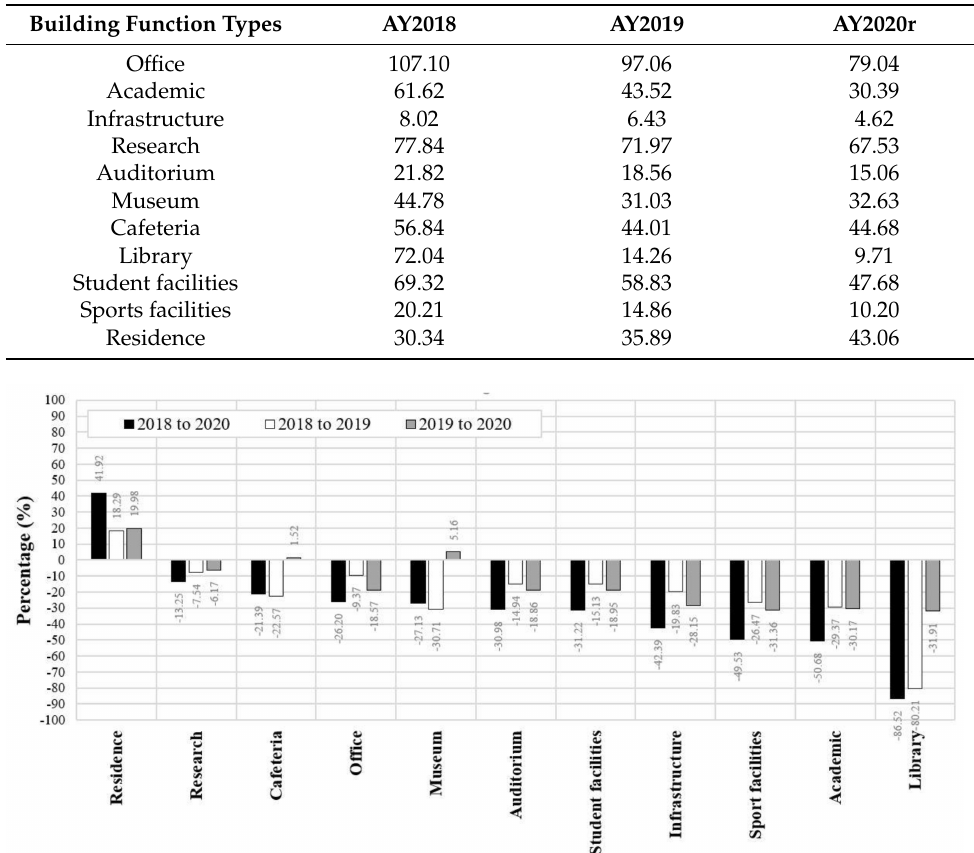
Figure 5. Comparison of Energy Use Index (kWh/m 2 -y) based on their building function types